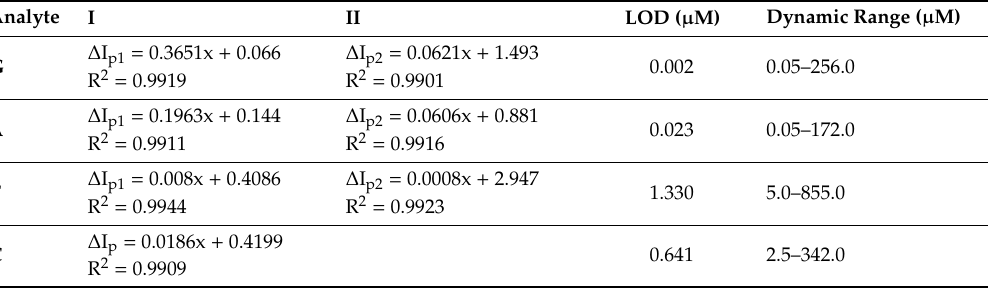
Table 2. Analytical performance of GCE/GONRs-CH in comparison with those reported in the literature.